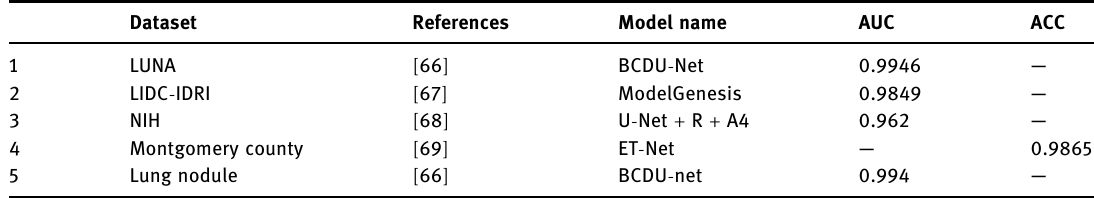
Table 4: Top 5 lung nodules segmentation models